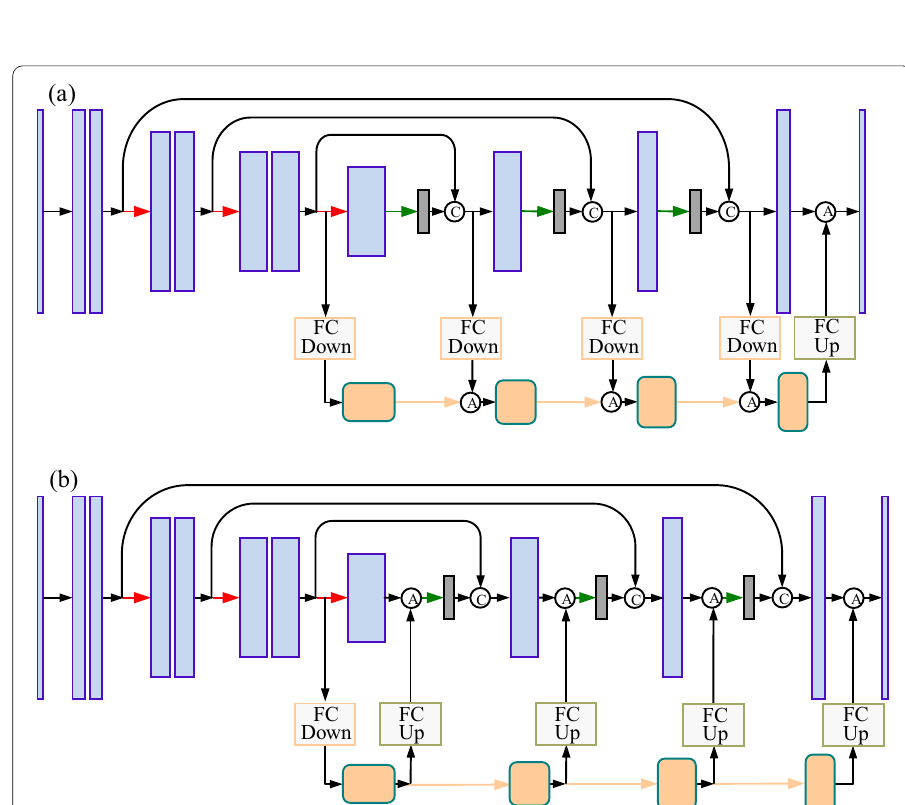
Fig. 5 Structural comparison of simplified dual-path hybrid networks: a Hybrid-A; b